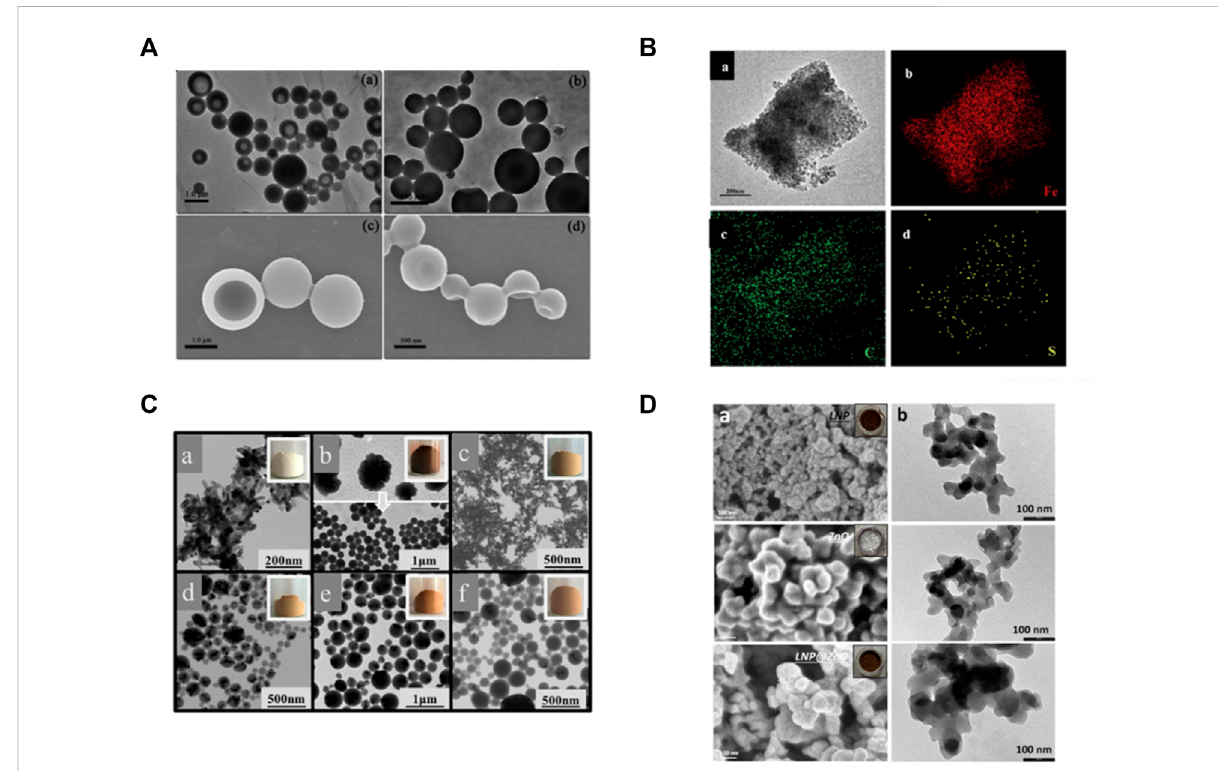
FIGURE 8 (A) TEM and SEM images of lignin hollow microspheres (LHM) prepared with unmodi fi ed larch (a,c) and poplar (b and d) lignin (Liet al., 2016) (B) TEM imageof MLS25% and EDS mapping patternsof MLS25% (Geng etal., 2019) (C) TEMand appearance images of (a) TiO 2 , (b) QAL and its colloidal spheres, (c) LCS@TiO 2 -1, (d) LCS@TiO 2 -2, (e) LCS@TiO 2 -3 and (f) LCS@TiO 2 -4 (Li et al., 2019) (D) FESEM (a) and TEM (b) images of LNP, ZnO, and ZnO@LNP (the inset images show the color change due to the formation of lignin-derived ZnO) (Del Buono et al., 2022). (A)